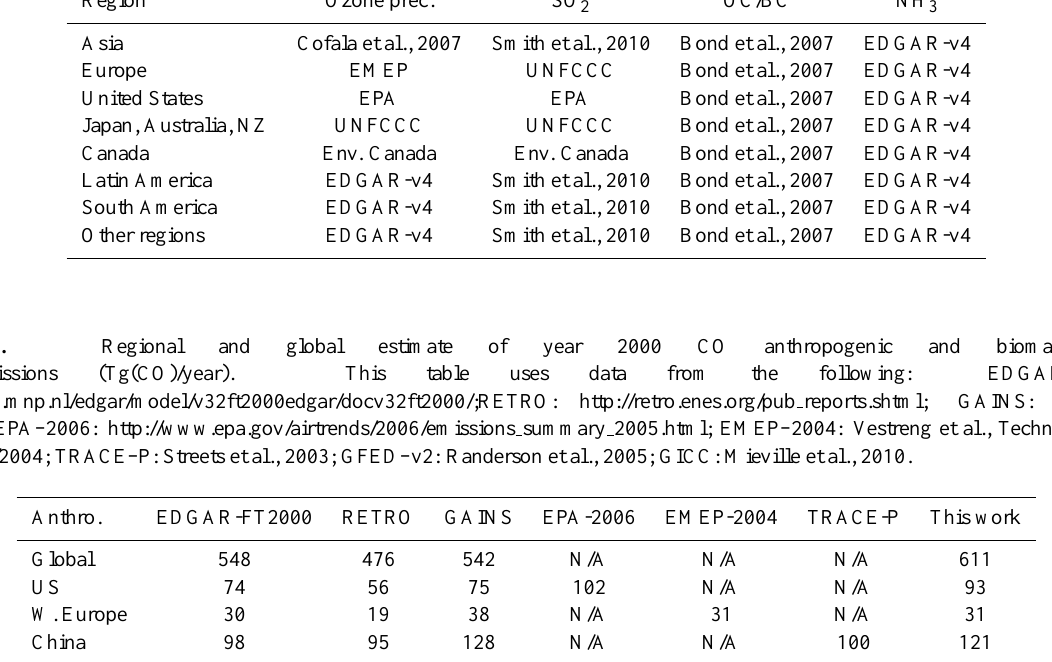
Table 4. Primary source of information for the various regional inventories used in the definition of the 2000 dataset. Region